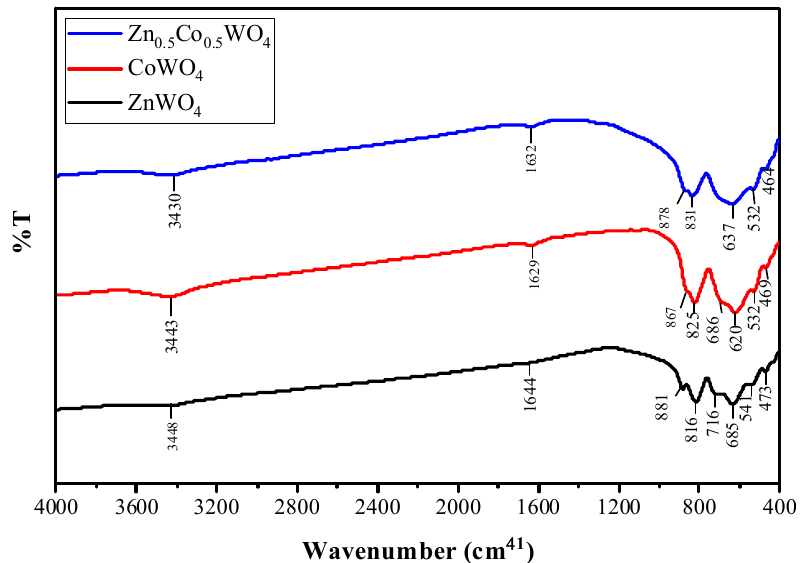
Figure 1. FTIR spectra of ZnWO 4 (black line), CoWO 4 (purple line), and Zn 0.5 Co 0.5 WO 4 (light blue line). The formation of ZnWO 4 , CoWO 4 , and Zn 0.5 Co 0.5 WO 4 was confirmed by the XRD analysis. Figure 2 shows the XRD pattern of the ZnWO 4 , CoWO 4, and Zn 0.5 Co 0.5 WO 4 pre- pared by the hydrothermal method at 180 ℃ for 24 h. The XRD spectra of ZnWO 4 shows